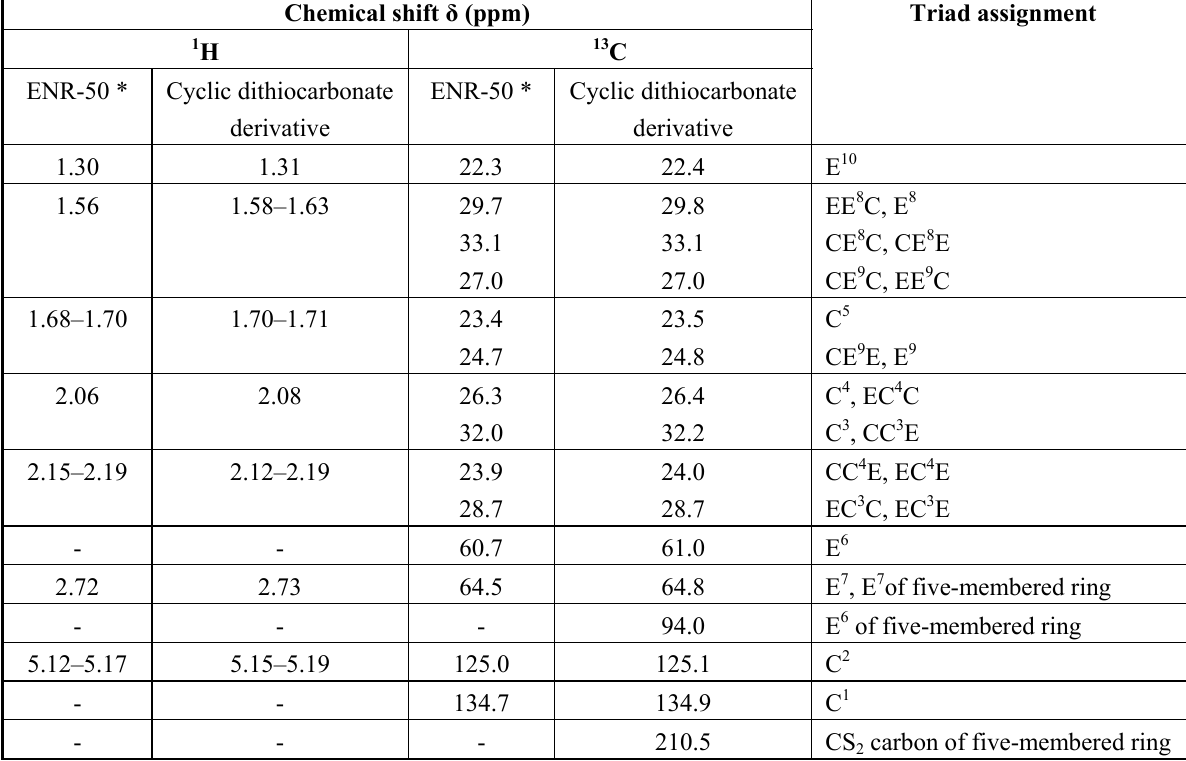
Table 2. 1 H and 13 C-NMR chemical shifts and triad assignments for purified ENR-50 and its cyclic dithiocarbonate